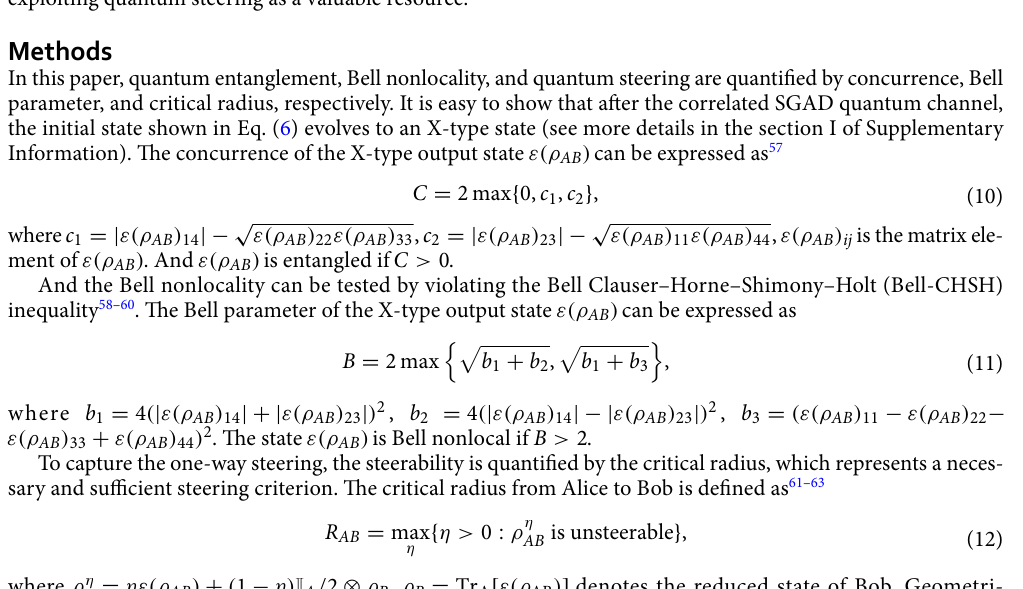
P A P B . h and hr represent the = −